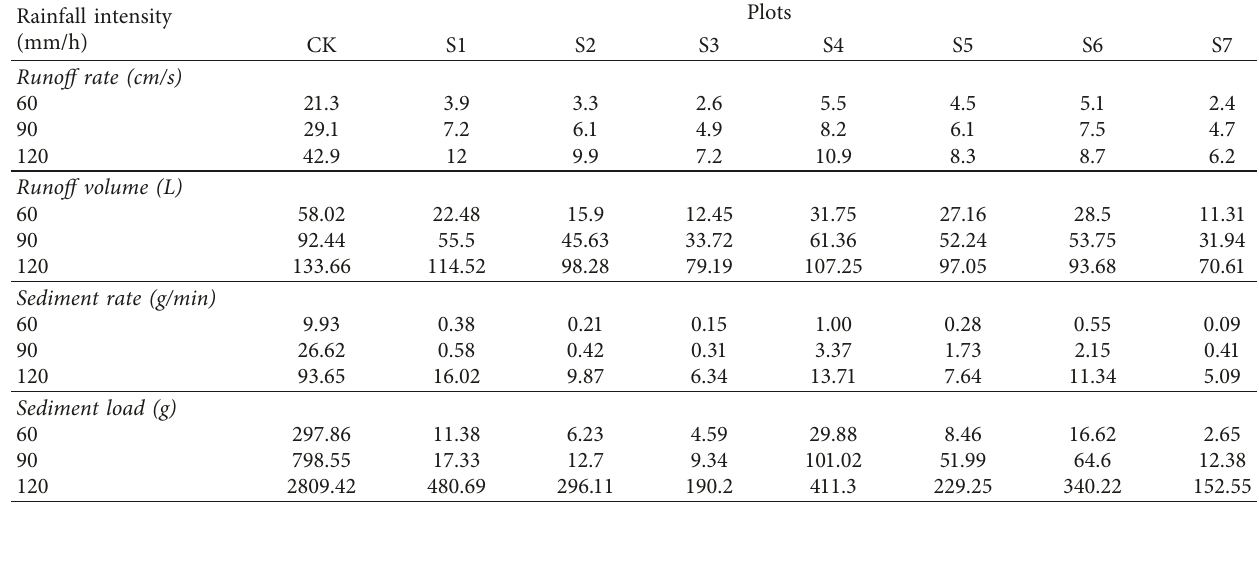
Table 2: Accumulated runoff volumes and sediment loads under different vegetation covers and rainfall intensities.